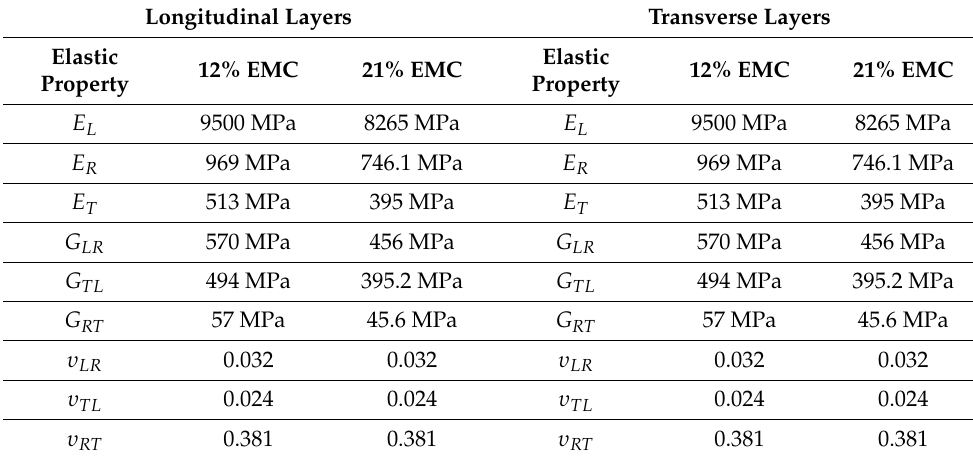
Table 9. 260 × 270 mm CLT material properties [18].